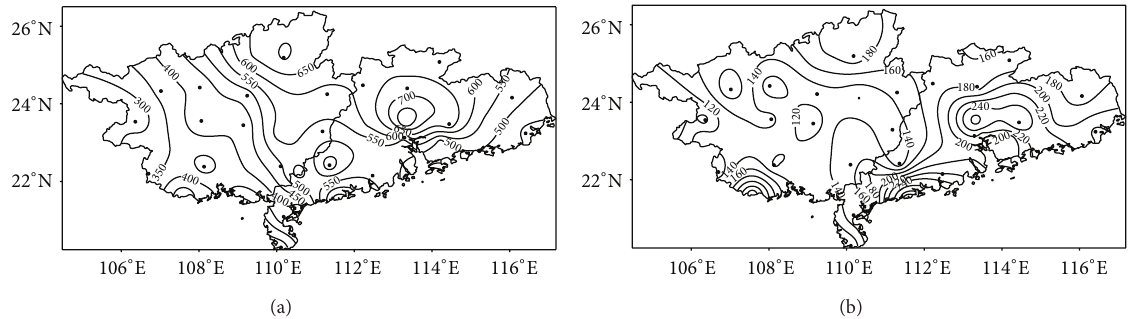
Figure 2: Long-term mean spring precipitation (a) and its standard deviation (b) in South China.